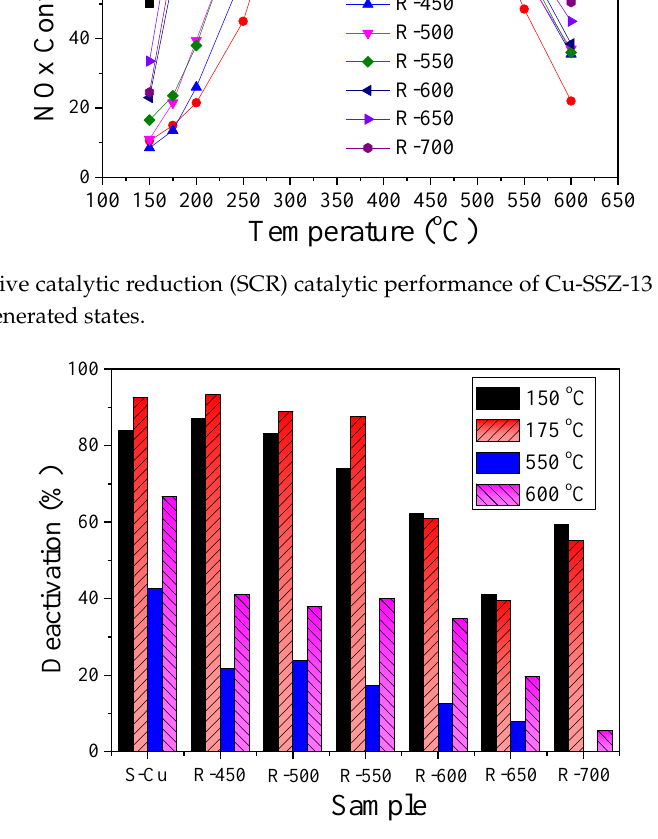
Figure 11. Deactivation evaluated at 150, 175, 550 and 600 °C of the sulfated and regenerated states of the Cu-SSZ-13 catalyst.